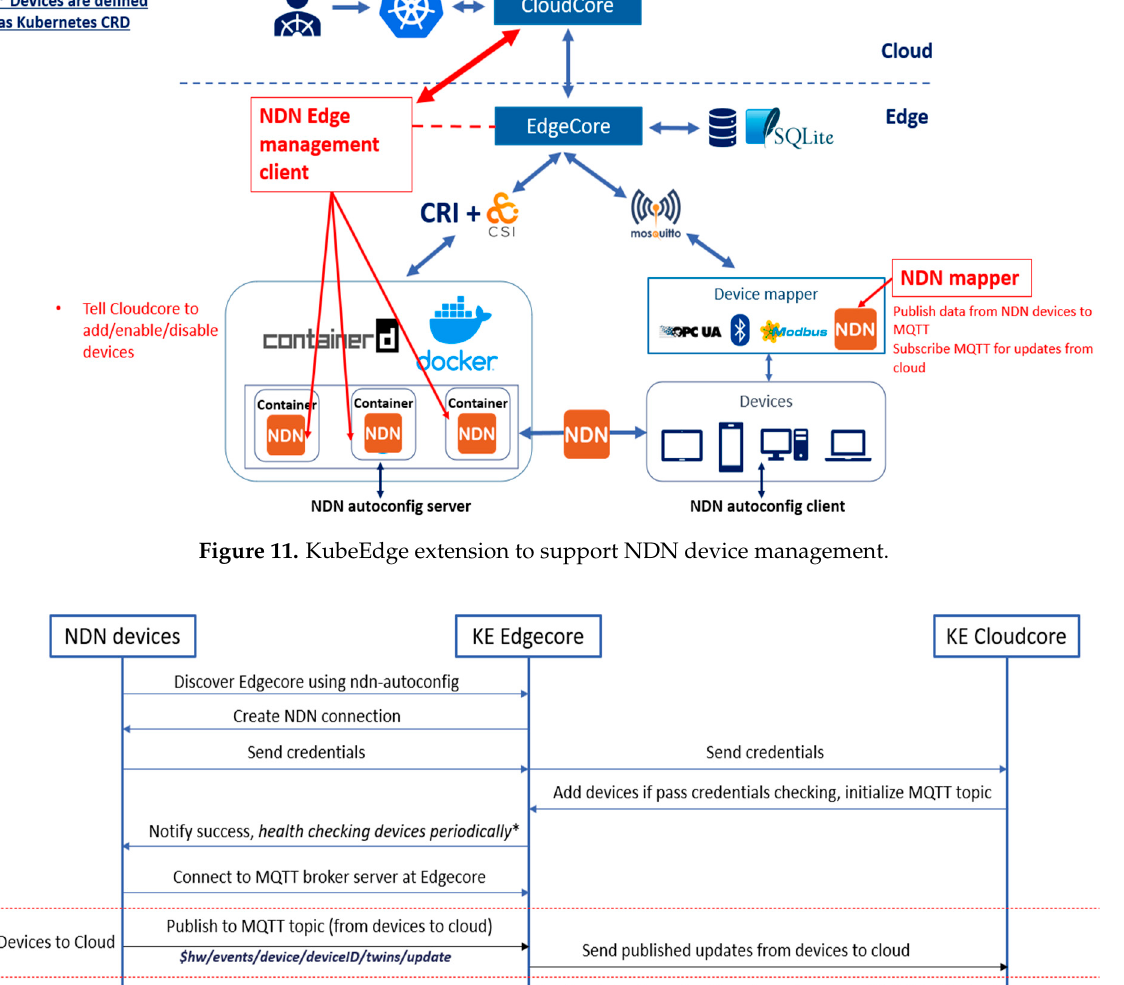
Figure 12. New NDN device management sequence diagram.